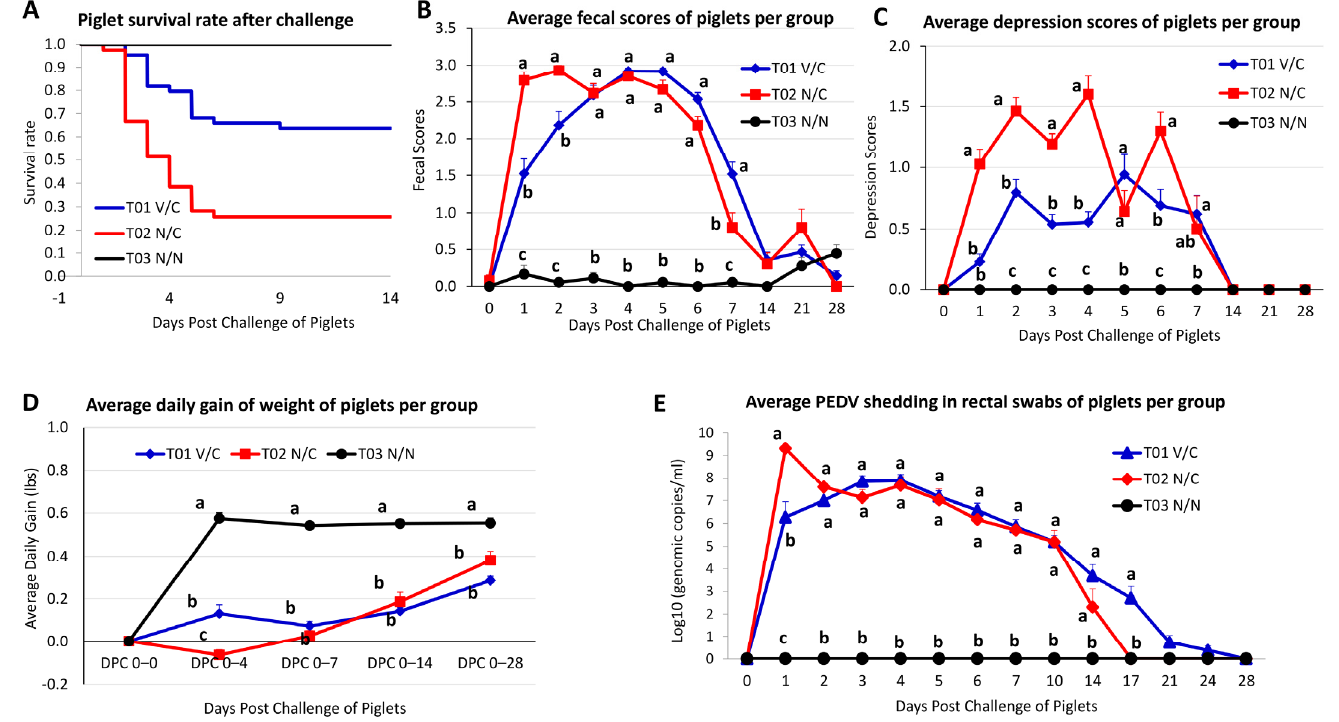
Figure 3. The survival rate, clinical signs, average daily gain, and viral shedding in piglets from the three experimental groups. Pregnant sows were orally vaccinated 5-weeks pre-farrowing and then boosted three weeks later. Piglets were challenged with virulent non-S-INDEL PEDV at 3 to 5 days of age. ( A ) Survival rate of piglets. ( B ) Average fecal score for diarrheal severity over time. ( C ) Average depression scores over time. ( D ) Mean average daily weight gain after challenge. Only piglets that survived through DPC 28 were included for weight comparison. ( E ) PEDV RNA titers in rectal swabs as determined by a quantitative PEDV N gene-based real-time RT-PCR. Virus titers represent the mean values of all available piglets in each group at each time point. For each figure, error bars indicate standard error, and different letters indicate significant differences.